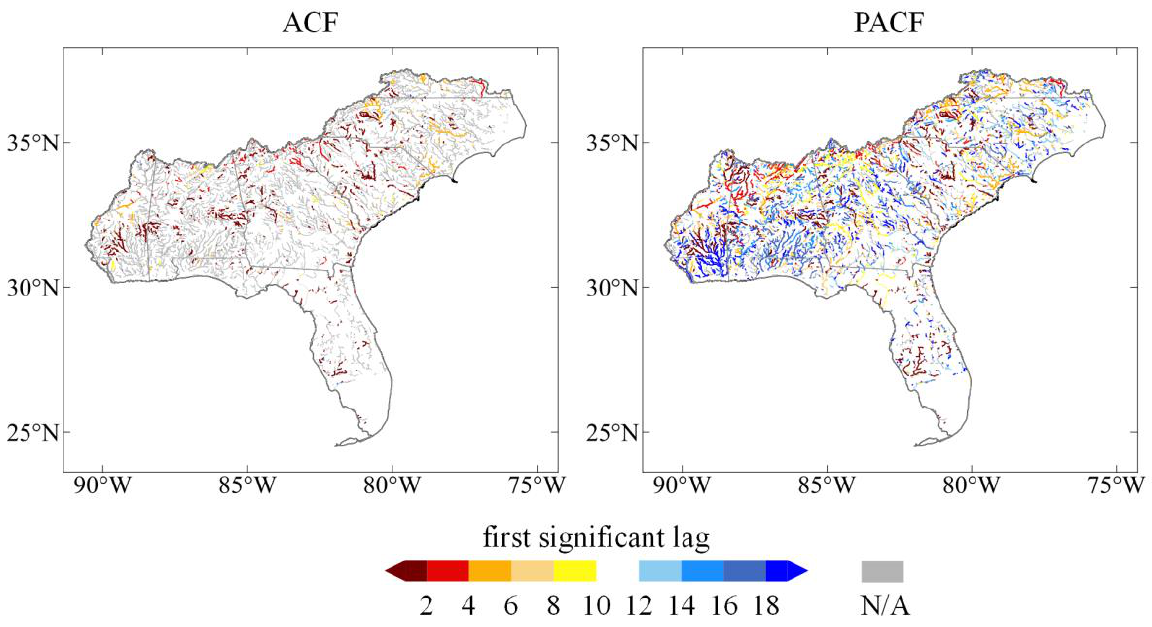
Figure 4. First significant lags for annual ACF and PACF in studied nodes.